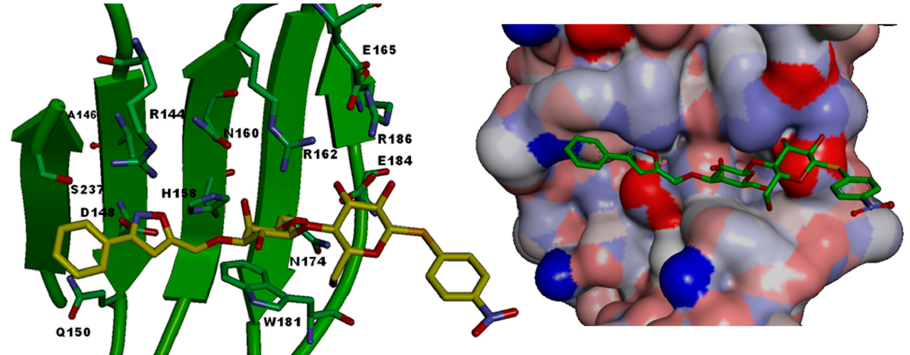
Figure 10. Schematic representation of the CRD site of human galectin-3 (PDB 3AYE) showing all amino acids involved as per Table 1 and interacting with compound 17 (docked in by superposition with natural lactose ligand); left Connolly surface representation with red surface (anionic) and blue surface (cationic amino acids).